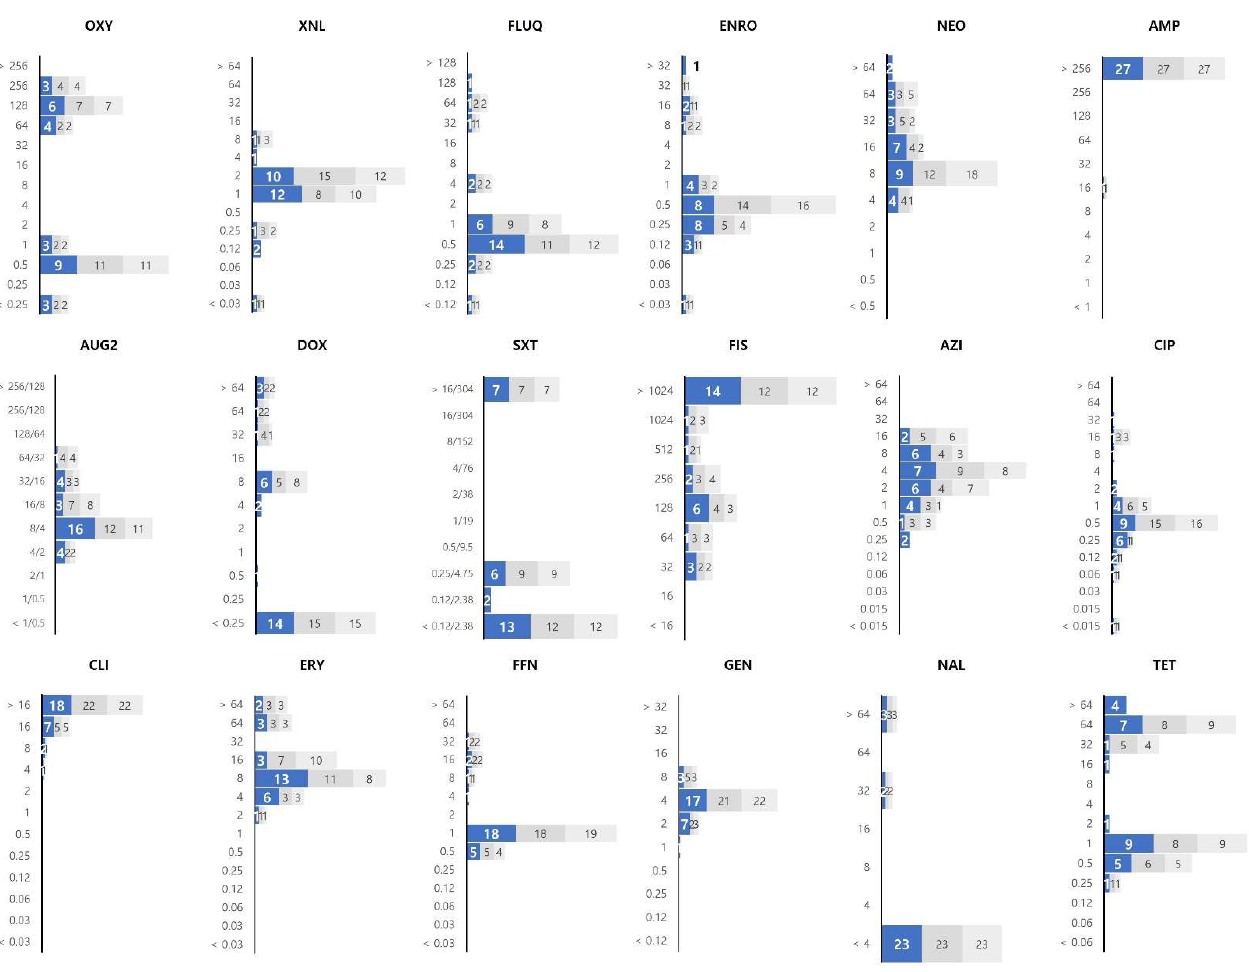
Figure 2. The MIC value distribution of 18 antibiotics against 28 strains of Vibrio spp. isolated from olive flounder. The X and Y axes of the graph represent the number of isolates and the MIC ( μ g/mL), respectively. The results of the experiment repeated in triplicate are shown in colour on the graph (1st: blue, 2nd: dark gray, 3rd: light gray). Oxytetracycline: OXY; ceftiofur: XNL; flumequine: FLUQ;